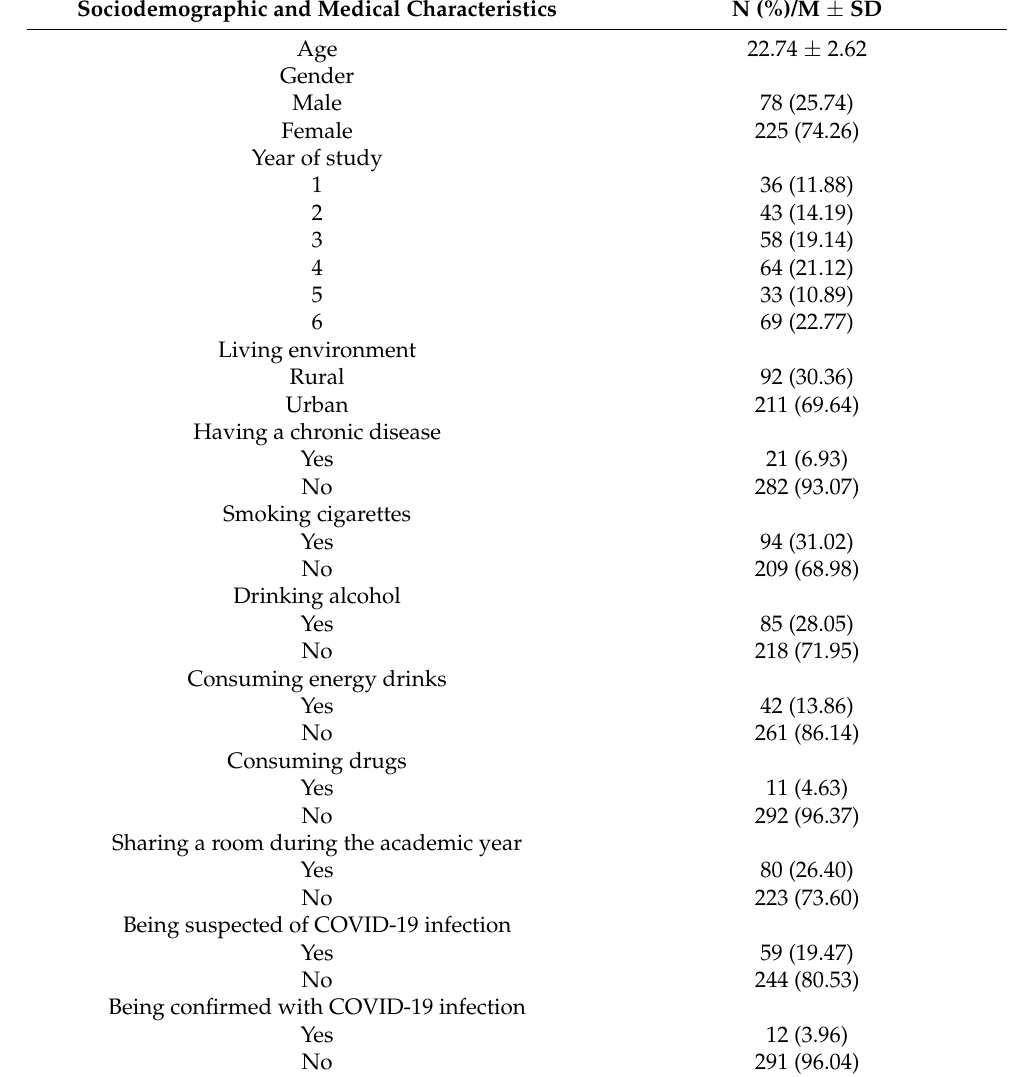
Table 1. Sociodemographic and medical characteristics 1